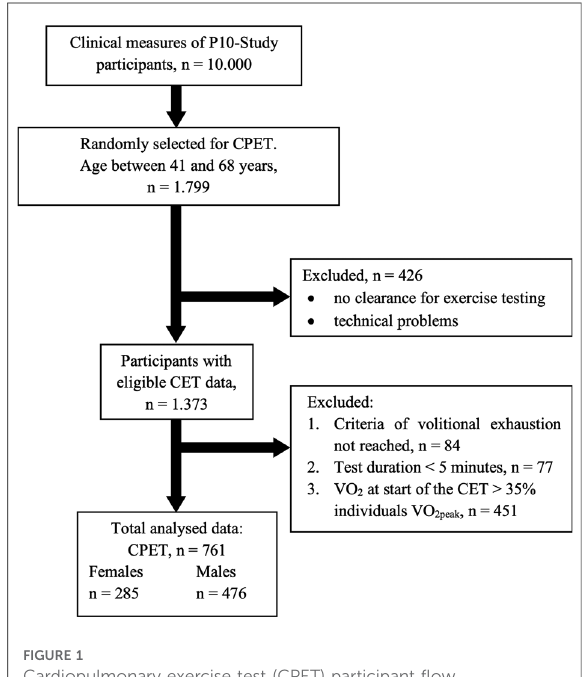
FIGURE 1 Cardiopulmonary exercise test (CPET) participant fl